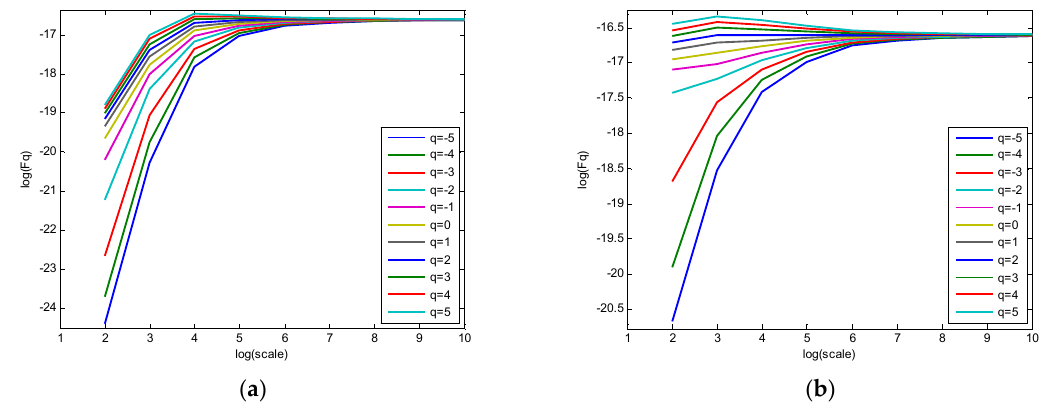
Figure 11. Double-log relation graph of low-frequency component d3 obtained using: ( a ) the traditional MFDFA algorithm; and ( b ) the new MFDFA algorithm.